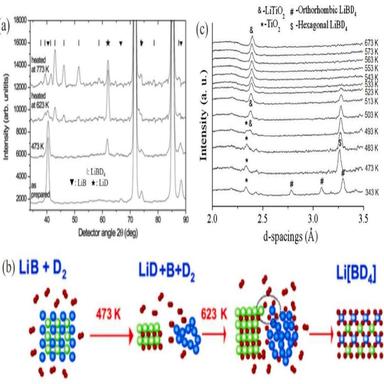
(a) In situ neutron diffraction patterns of LiBD4 with temperature elevation; (b) Schematic view of the reaction between LiB and D2: the initial LiB decomposes partially at 473 K and forms LiD; LiD then reacts with B and D2 above 623 K to form LiBD4 which is the most stable phase thermodynamically in the Li-B-D ternary phase diagram; (c) In situ neutron diffraction patterns of LiBD4-TiO2 (mass ratio 1:4). The heating rate was 275 K/min .